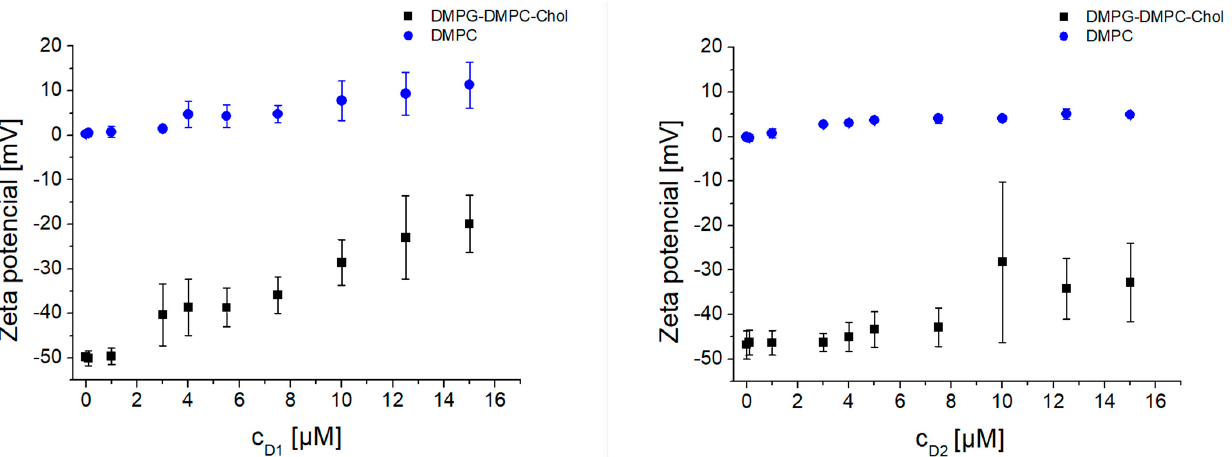
Figure 5. Zeta potential of zwitterionic DMPC liposomes and negatively charged DMPG − DMPC − Chol liposomes upon the increasing concentration of D1 ( left ) and D2 ( right ) dendrons in Na-phosphate buffer (10 mM, pH 7.4) at 25 °C. Error bars represent standard deviations.